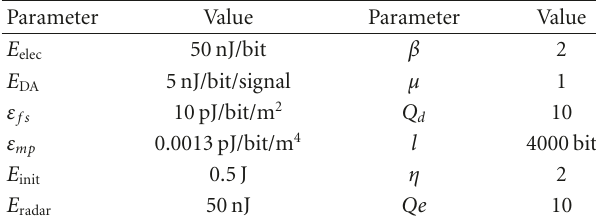
Table 1: Parameters of